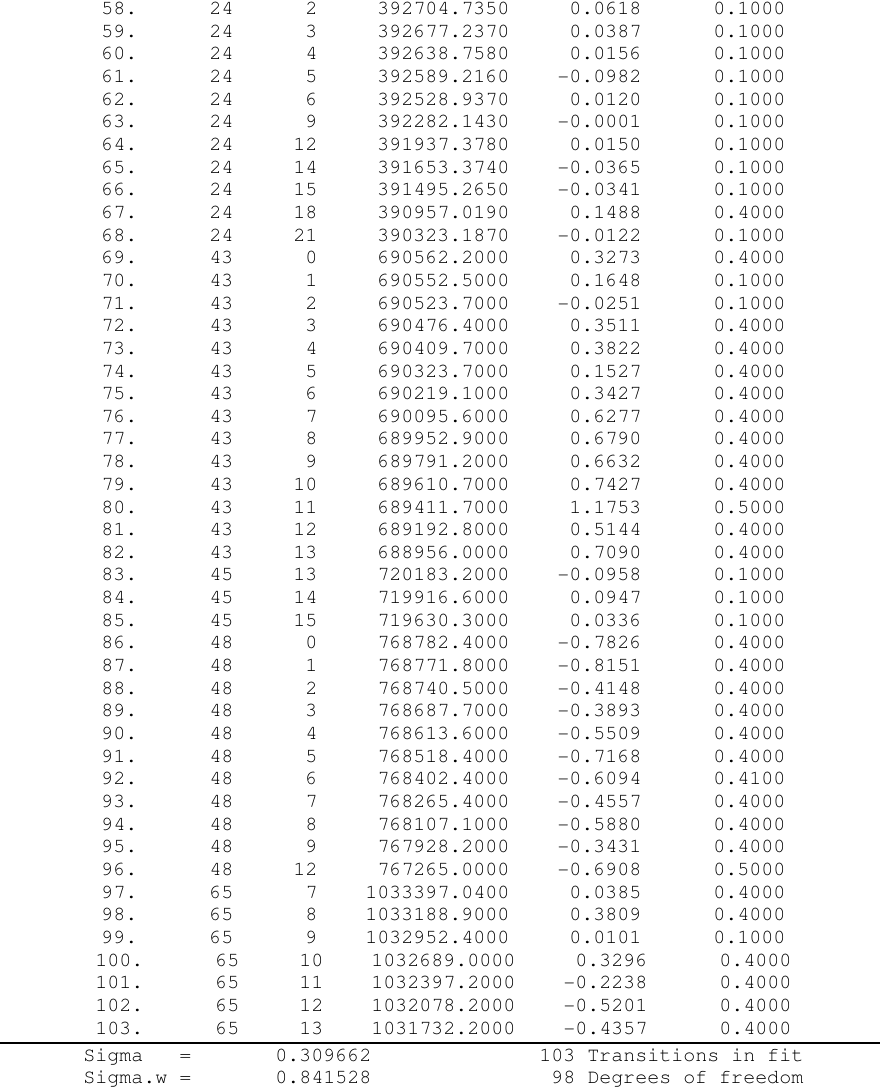
Table 11 . Comparison of rotational parameters of CD